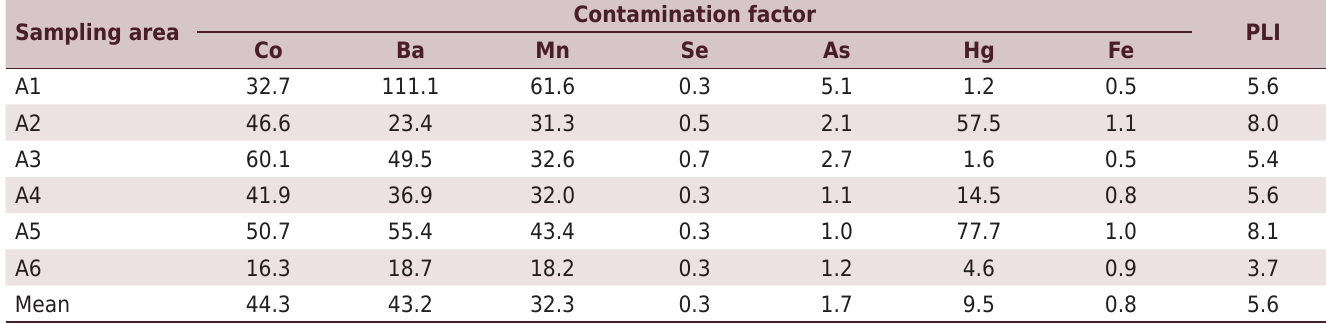
Table 5. Contamination factor (CF) for potentially toxic elements and pollutant load index (PLI) in soils and sediments for the 0.00-0.20 and 0.20-0.40 m layers from Serra Pelada Sampling area